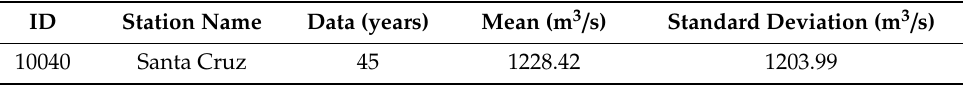
Table 3. Mean and standard deviation of Q for hydrometric station 10040.